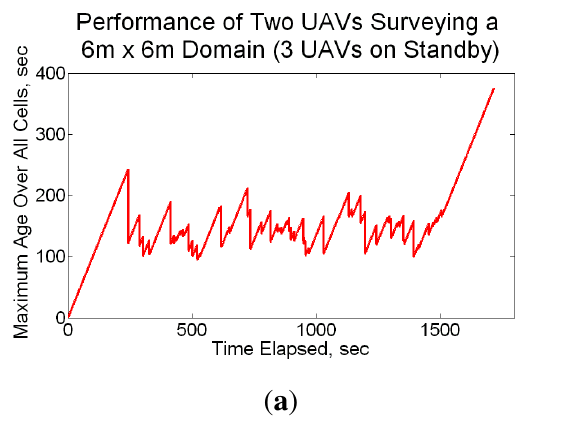
Figure 27. Performance of two UAVs surveying the target space with 3 UAVs on standby. Plot ( a ) shows the maximum age over all cells as a function of time. Plot ( b ) shows the health of the UAVs and the time they are active against experiment time. ( a ) Performance; ( b ) Health and Active Time of